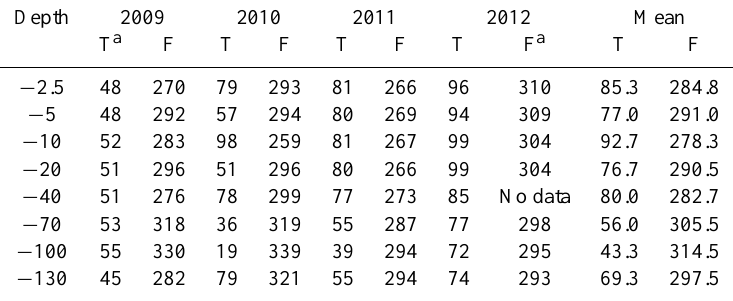
Table 3. Length in days of the freezing (F) and thawing (T) seasons at different depths (in cm), and mean value for the studied period.